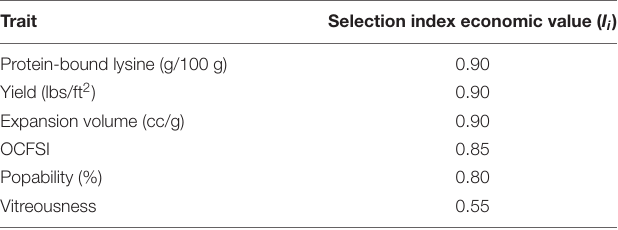
TABLE 3 | Economic Values assigned for traits in 2020 Ranking System.